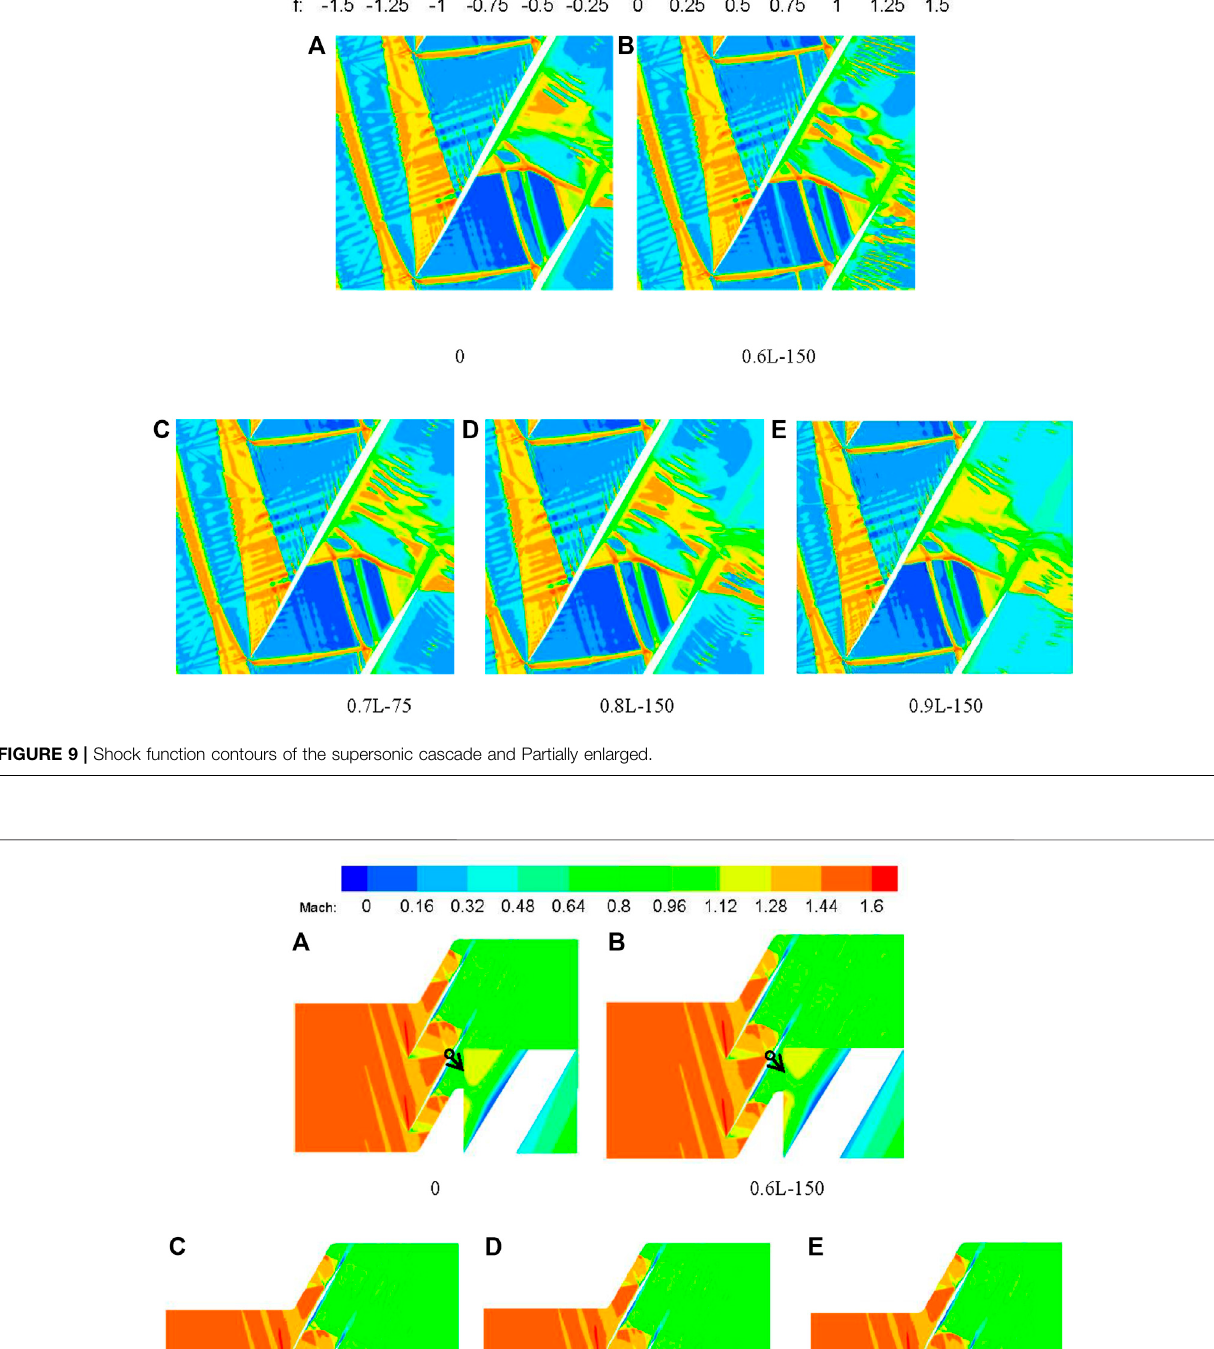
Frontiers in Energy Research |